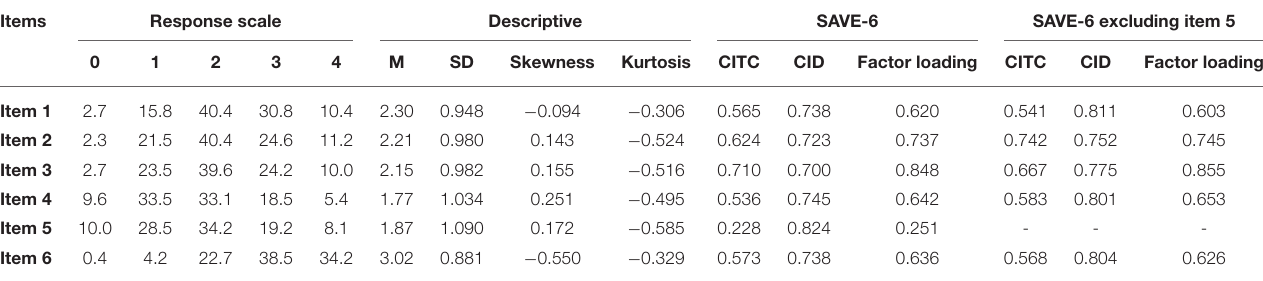
TABLE 2 | Factor structure of the Peruvian Spanish versions of SAVE-6 and SAVE-6 excluding item